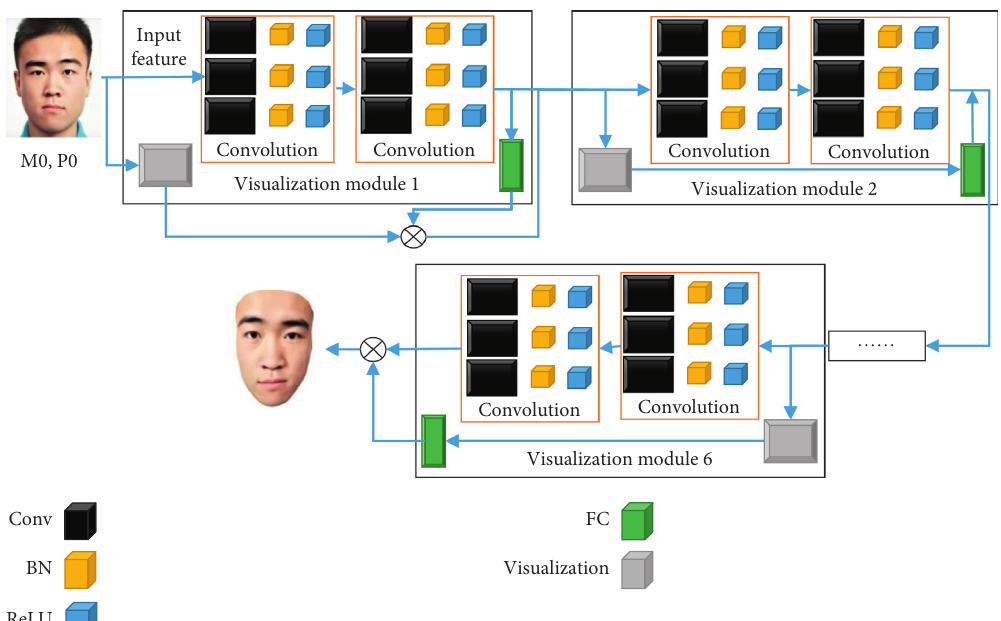
Figure 1: The neural network structure diagram proposed in this paper.